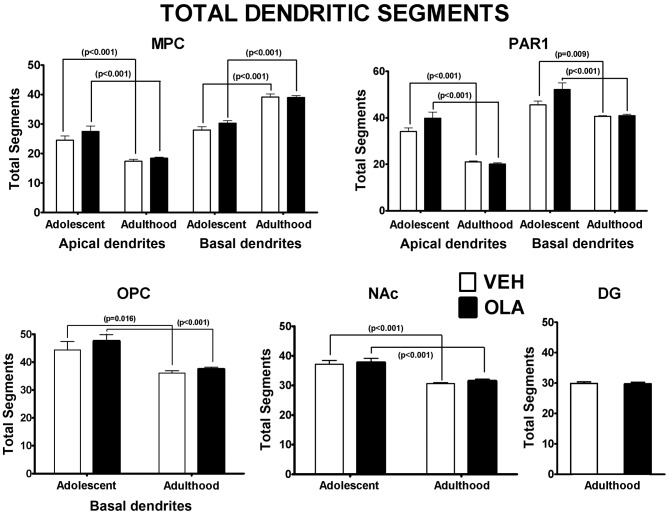
Total number of dendritic segments.There were no statistically significant effects of treatment in adolescents or adults. p-values above brackets indicate the significance of age related changes. All p-values are based on paired t-tests corrected for multiple comparisons. Error bars are standard error of the mean.